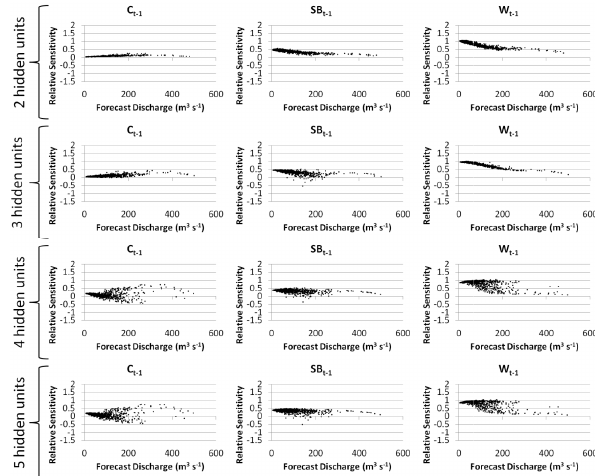
Figure 13. Global-local relative sensitivity plots for all candidate models in Scenario B: cross-validation data.